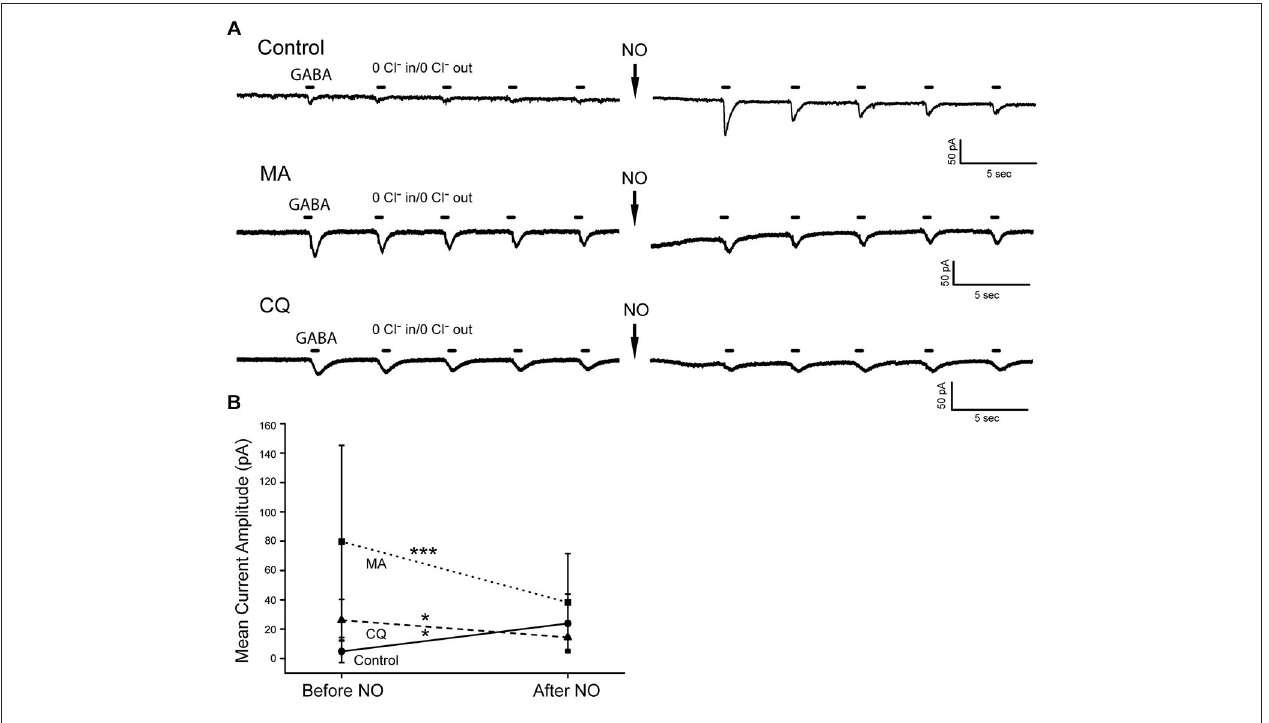
the current is enhanced. In contrast, MA and CQ containing cells had larger GABA-gated currents before NO. After NO, the currents were not enhanced but rather significantly reduced in amplitude. (B) Mean current amplitudes are plotted before and after exposure to NO for control, MA and